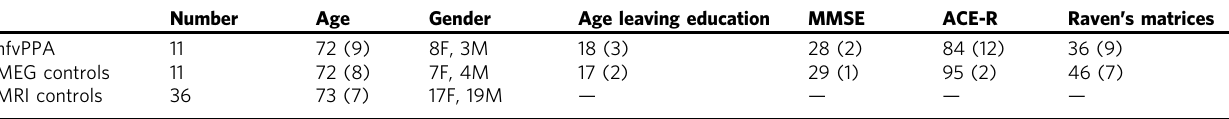
Table 1 Demographic details of the experimental